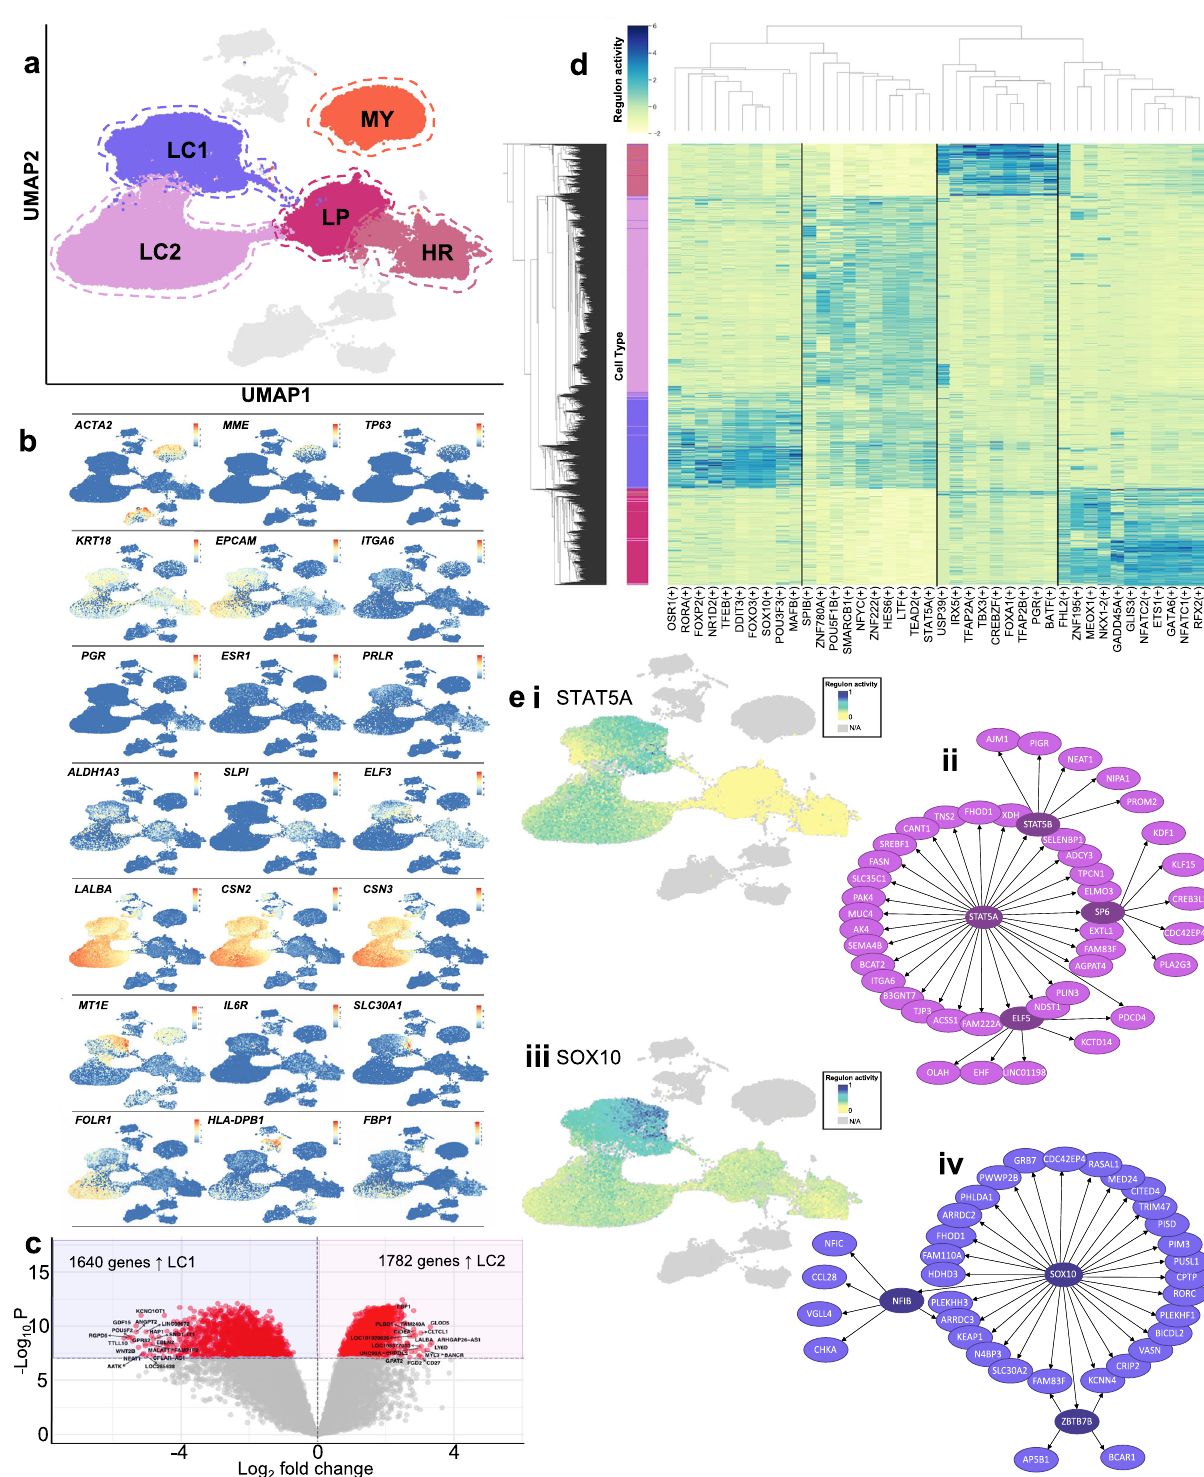
Fig. 2 Clustering analysis of non-lactating (NMC) and lactation-associated (LMCs) mammary epithelial cells reveals different subpopulations arising from different developmental stages. a Five major epithelial clusters were identi fi ed in our data set consisting of NMC myoepithelial (MY), luminal hormone-responsive (HR) and luminal progenitor (LP) clusters and LMC major luminal clusters 1 and 2 (LC1 and LC2). b Uniform manifold approximation and projections (UMAPs) coloured by marker genes characterizing the various clusters. c Volcano plot displaying the fi ndings of the differential gene expression analysis revealed 1640 genes more highly expressed in LC1 compared to 1782 genes highly expressed in LC2. Signi fi cant genes are in red with the top 10 being annotated. d Top 10 regulons signi fi cantly upregulated in each luminal cell cluster. e Signi fi cant regulons found in LCs. i UMAP of STAT5A regulon activation in luminal cells and ii genes associated with STAT5A regulon. iii UMAP of SOX10 regulon activation in luminal cells and iv genes associated with SOX10